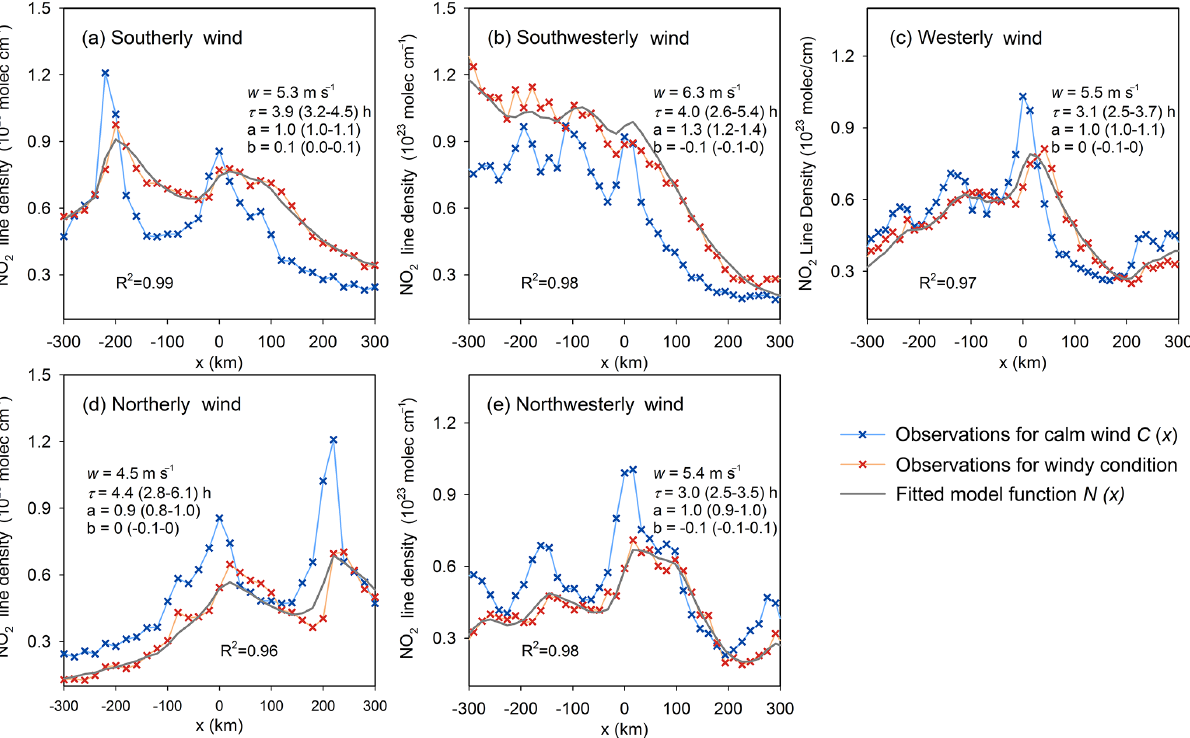
Figure 2. NO 2 line densities around Harbin for different wind direction sectors. Crosses: NO 2 line densities for calm (blue) and (a) southerly, (b) southwesterly, (c) westerly, (d) northerly, and (e) northwesterly (red) winds as a function of the distance x to Harbin center. Grey line: the fit result N(x) . The numbers indicate the net mean wind velocities (windy – calm) from ECMWF ( w) , the lifetime τ , the factor a and offset b resulting from the least-squares fit with 95% confidence interval. NO 2 line densities for the remaining wind direction sectors are dismissed due to missing data (see the criteria of “reliability” defined in Sect. 2.2.2).